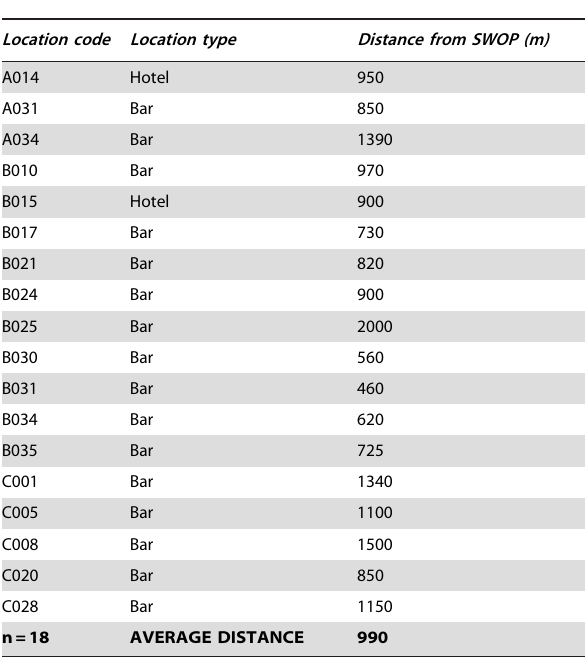
Table 3. Distance of selected hot spots from the SWOP City